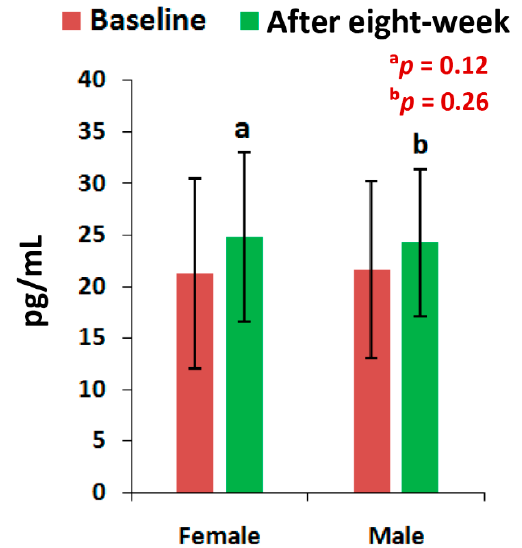
Figure 4. Levels of Vitamin-D of 63 experimental subjects, female ( n = 39) and male ( n = 24), before and after eight-week using supplement ( a p = 0.12, b p = 0.26).